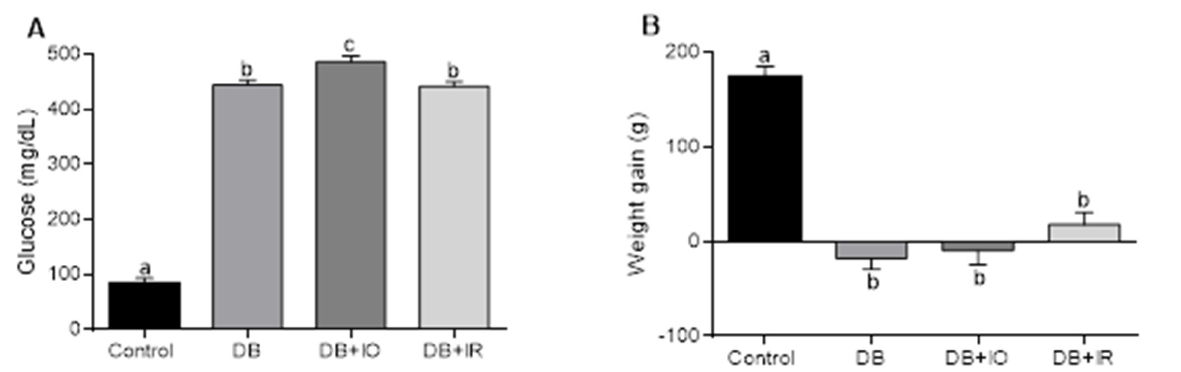
Figure 1. Fasting serum glucose ( A ) and Weight gain ( B ). Weight gain was determined by subtracting the animals’ weight after eight-week treatments with the diets, determined right before sacrifice, minus the weight at the beginning of the treatments. Data are expressed as the mean ± standard error. p < 0.05 ( n = 6, ANOVA plus Tukey’s post hoc test). DB + IO, diabetic rats with iron overload; DB + IR, diabetic rats with iron—restricted diet. Different letters (a–c) represent statistically significant differences.